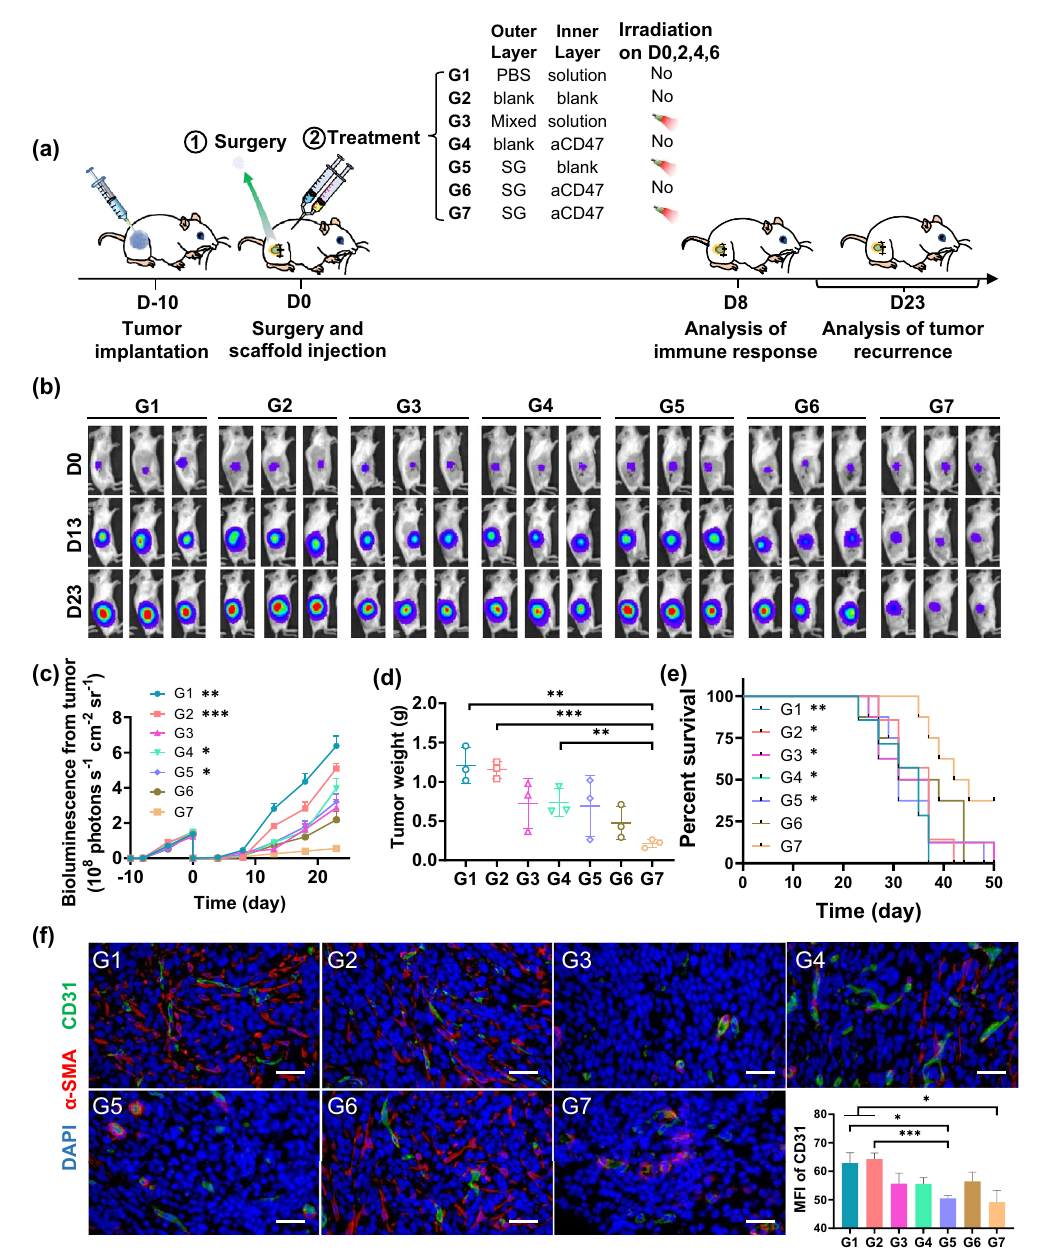
Fig. 4 Sequential delivery of combined immunotherapy for inhibiting recurrence of 4T1 carcinoma tumor after surgery. a Schematic illustra- tion of the animal experimental design. DLG outer layer: 50 μL; DLG inner layer: 50 μL; Dose of sorafenib: 2.5 mg kg −1 ; Dose of aCD47: 3.5 mg kg −1 . b In vivo bioluminescence imaging of tumor resected mice receiving various treatments (G1–G7) after surgery. Three representa- tive mice in each treatment group are shown. Images associated with Day 0 were taken on the day of surgery. c Tumor growth curves with the mean tumor volumes of 4T1 tumor-bearing BALB/c mice model. Data are shown as mean ± SEM ( n = 5). Data difference is shown comparing to G7. d The recurrence tumor weights of different groups obtained from the 4T1-tumor resection mice on Day 23 after treatment. Data are shown as mean ± SEM ( n = 3). e The survival percentages corresponding to the tumor volume of the 4T1-tumor resection mice ( n = 8). Data difference is shown comparing to G7. f Immunofluorescence staining for tumor microvessels in tumor tissue on Day 8 after different treatments. The vas- cular endothelial cells were stained with the FITC-anti-CD31 antibody (green) and the vascular smooth muscle cells were stained with Cy5-anti- α-SMA antibody (red) and the cell nucleus was stained with DAPI (blue) (Scale bar: 100 μm). The comparison of two groups was followed by student’s t test (two-tailed). * p < 0.05, ** p < 0.01, and *** p <